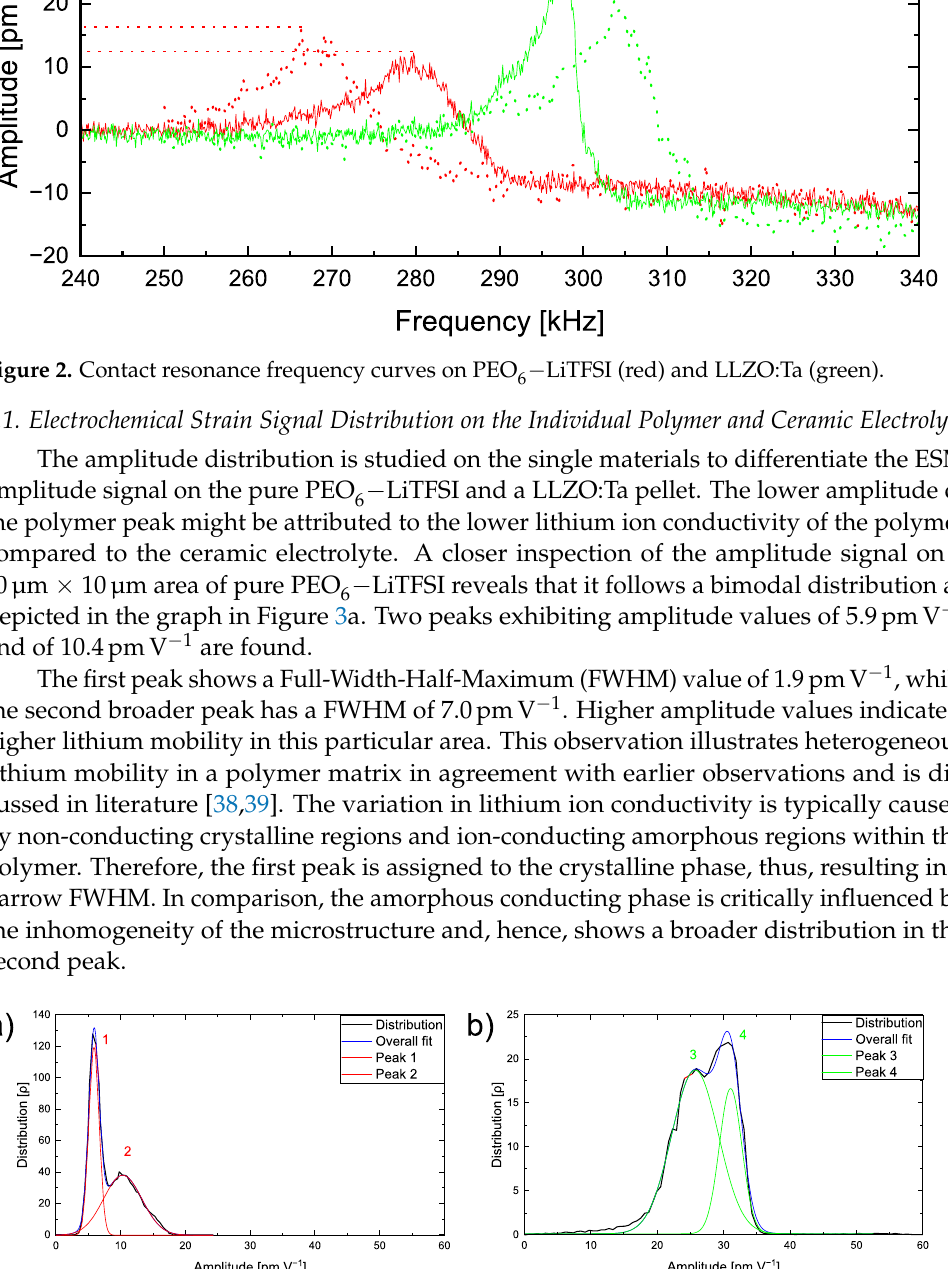
Figure 3. ( a ) Graph with the amplitude distribution of a 10µm × 10µm area on a pure PEO electrolyte film and ( b ) graph with the amplitude distribution of a 500nm × 500nm area on a LLZO:Ta